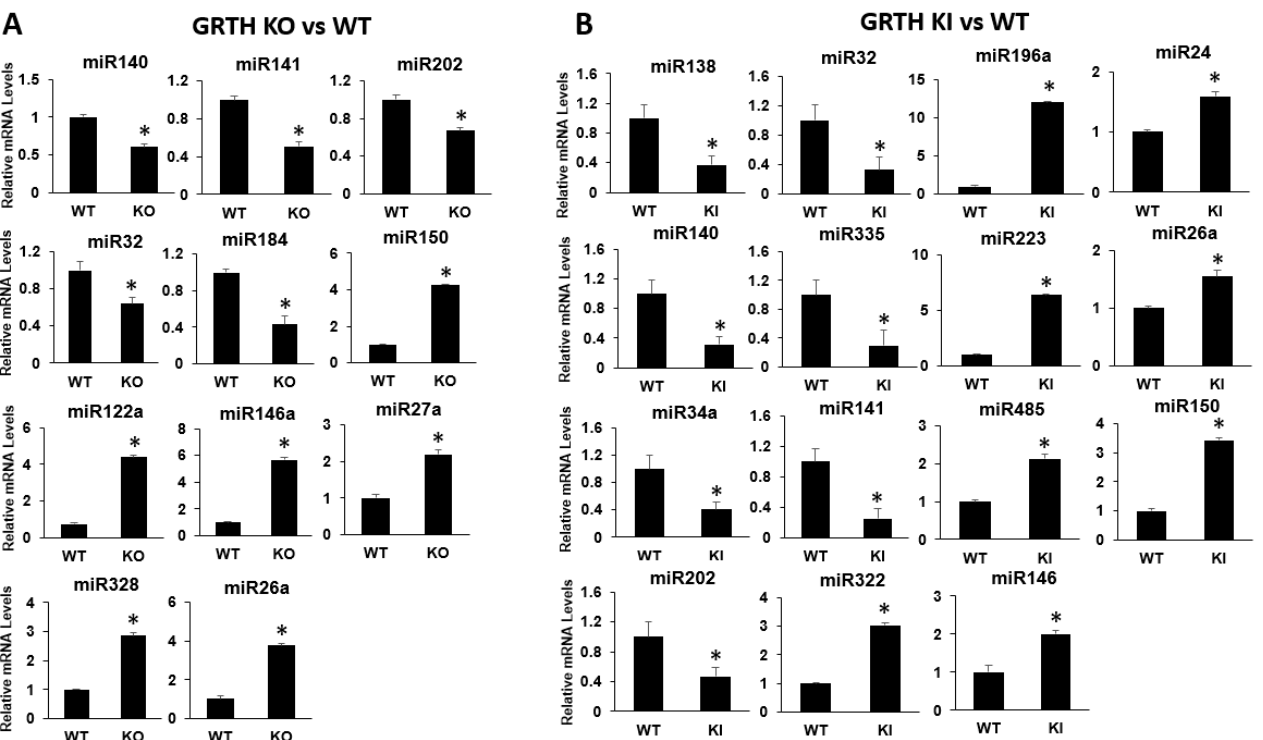
Figure 5. qRT-PCR analysis of selected miRNAs from RS of KO and KI groups. Bar graphs represent the fold change expression between ( A ) KO vs. WT or ( B ) KI vs. WT groups. Means ± SEM were determined from three independent qRT-PCR experiments with each sample run in triplicates using LNA probes. p values were calculated by two-tailed Student t-test (asterisks indicate p < 0.05).